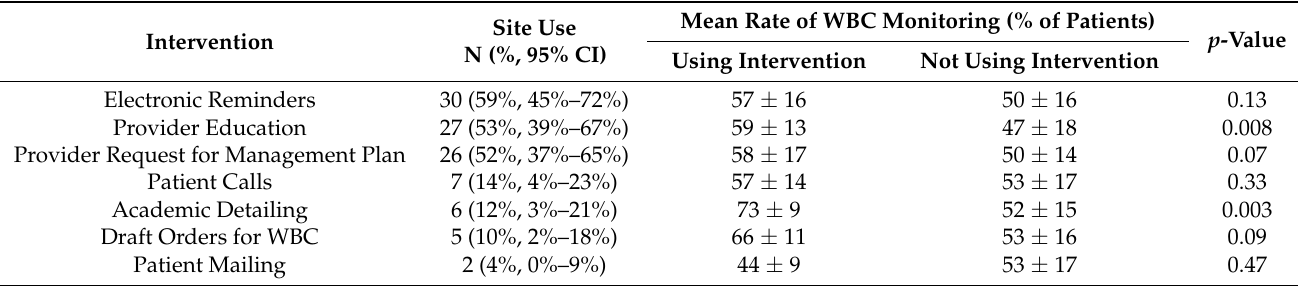
Table 1. UseandEffectivenessofInterventionstoImproveWBCMonitoringAmong51ParticipatingSites. (CI = Confidence Interval).